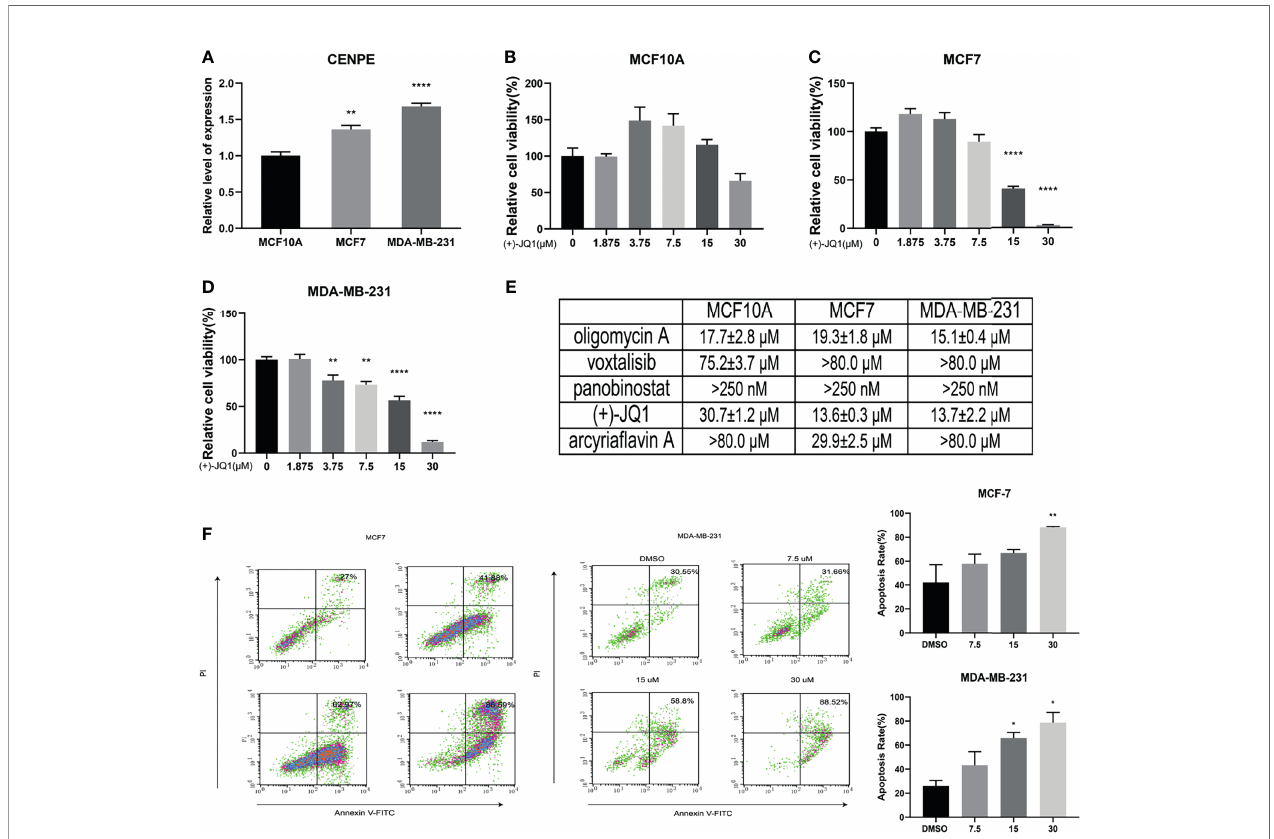
FIGURE 7 | Biological veri fi cation of the association between methylation-driven genes and potential compounds. (A) The mRNA expression levels of CENPE in different cell lines. (B) The effects of (+)-JQ1 on the viability of MCF10A cells. (C) The effects of (+)-JQ1 on the viability of MCF7 cells. (D) The effects of (+)-JQ1 on the viability of MDA-MB-231 cells. (E) The IC 50 values of selected compounds in different cell lines. (F) The effects of (+)-JQ1 on apoptosis in MCF7 and MDA-MB- 231 cell lines. * P < 0.05; ** P < 0.01; **** P <